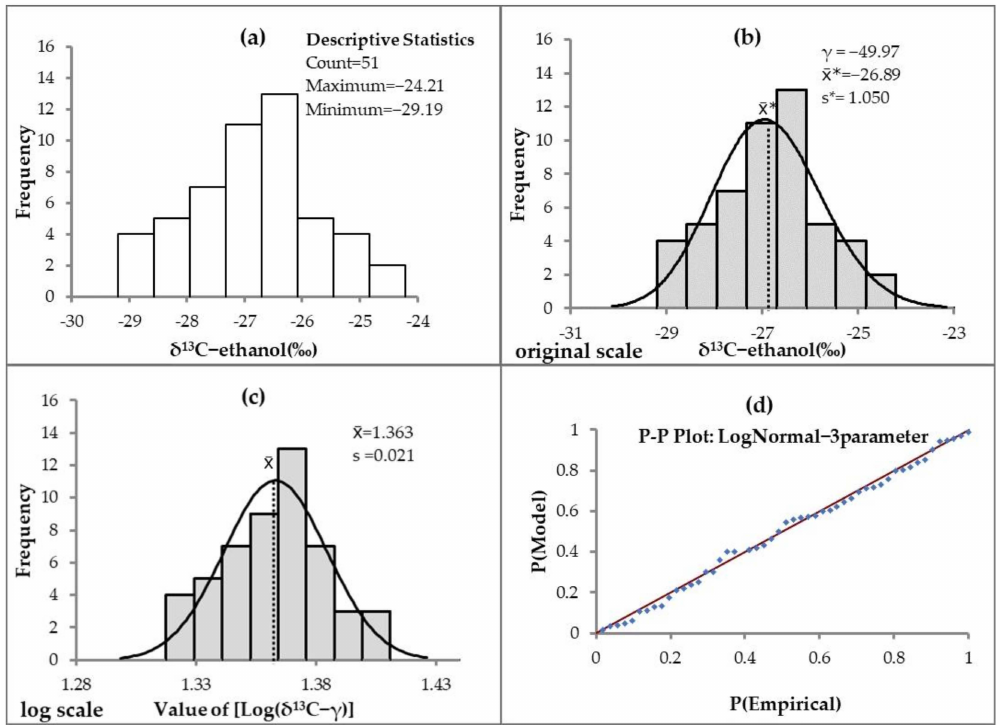
Figure 2. Statistical evaluating results of authentic single malt Scotch whiskies. ( a ) The histogram of δ 13 C − ethanol. ( b ) The distribution of observed δ 13 C − ethanol. ( c ) The distribution of transformed δ 13 C − ethanol. ( d ) The P-P plot of δ 13 C −